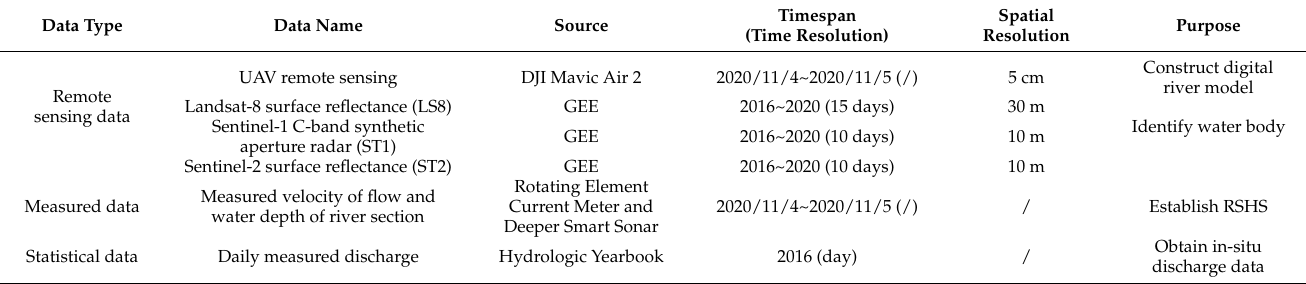
Table 1. Datasets